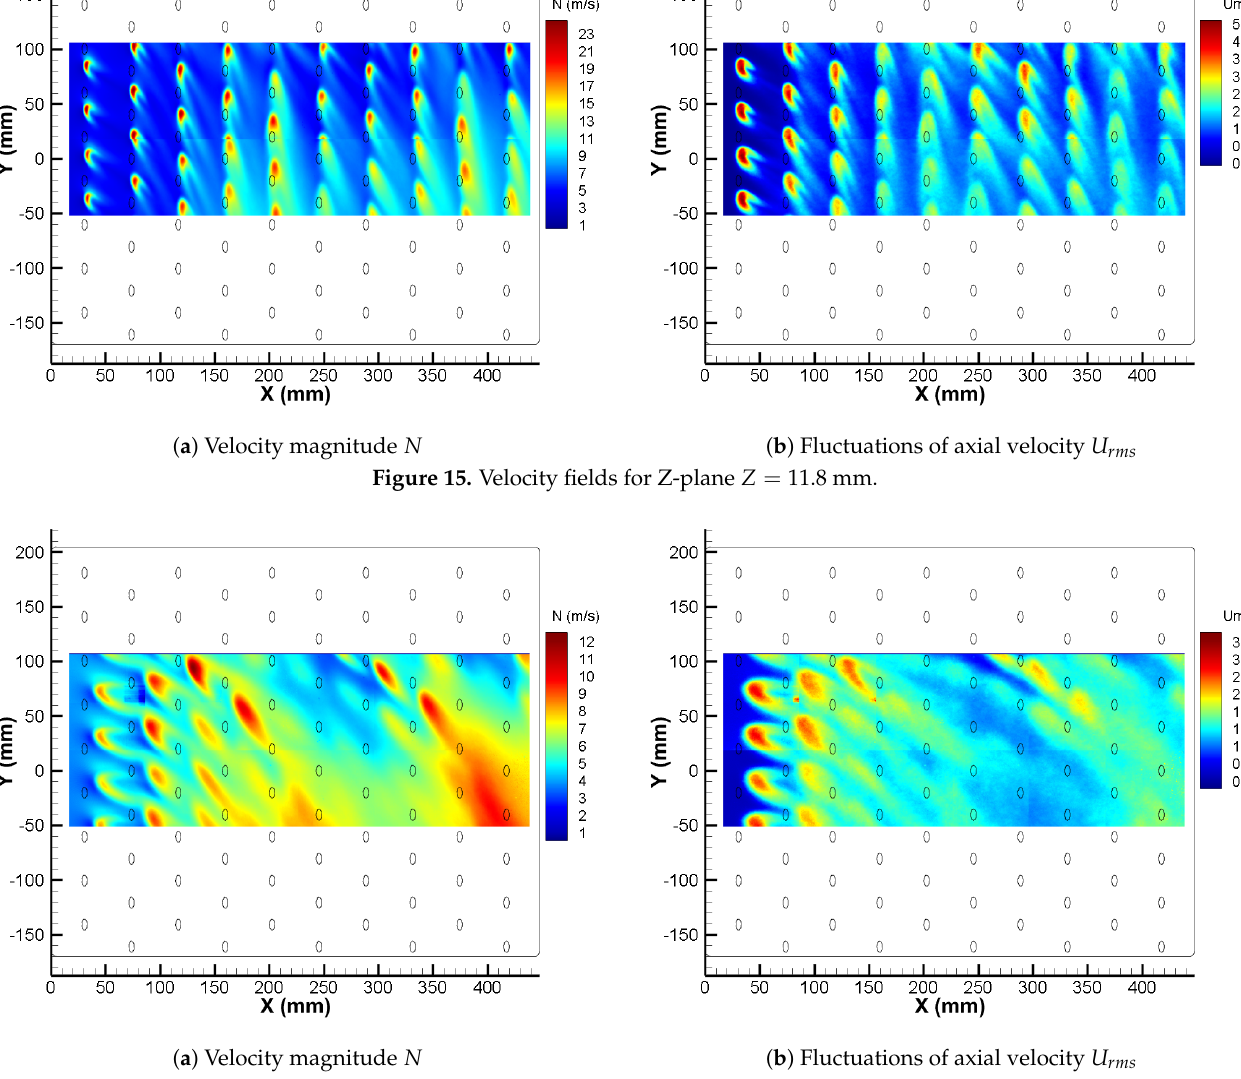
Figure 16. Velocity fields for Z-plane Z = 26.8